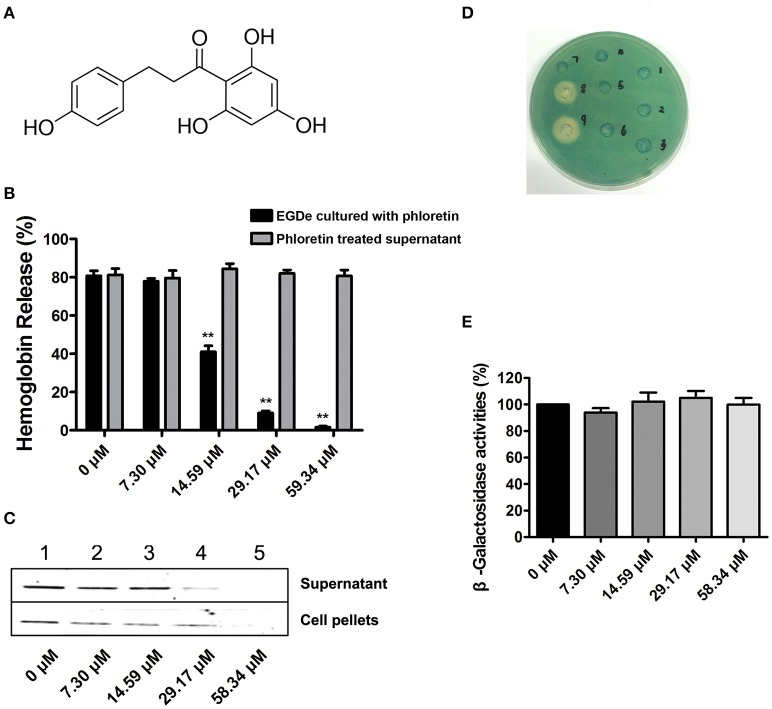
Phloretin inhibits LLO expression in L. monocytogenes. (A) The chemical structure of phloretin. (B) The effect of phloretin on the hemolytic activities of bacterial culture supernatants. Inhibition of hemolytic activity in culture supernatants of L. monocytogenes after co-culture with phloretin. L. monocytogenes was co-cultured with various concentrations of phloretin until reaching a stationary phase, and the hemolytic activities of the culture supernatants from each sample were determined using hemolysis assays. However, no inhibition of hemolytic activity for bacterial culture supernatants was observed following a direct pre-incubation with various concentrations of phloretin. (C) Western blotting analysis to detect LLO levels in culture supernatants and cell pellets. L. monocytogenes was co-cultured with various concentrations of phloretin until reaching a stationary phase, and the LLO level in the culture supernatants and cell pellets were determined by immunoblotting. Lanes 1–5, samples treated with 0, 7.30, 14.59, 29.17, and 58.34 μM phloretin. (D,E) No inhibition of hly transcription was produced by phloretin. Bacteria containing phly-lacZ plasmids were incubated with various concentrations of phloretin in TSB agar (D) or TSB (E). (D) Phloretin was added at increasing concentrations in wells 1–6 (0–116.68 μM); well 8 contained a 40% benzalkonium bromide solution; and well 9 contained a 60% benzalkonium bromide solution. (E) β-galactosidase activity was evaluated using a β-galactosidase staining kit and the values were obtained by comparing with data of phloretin-free samples (taken as 100%). *P < 0.05; **P < 0.01.